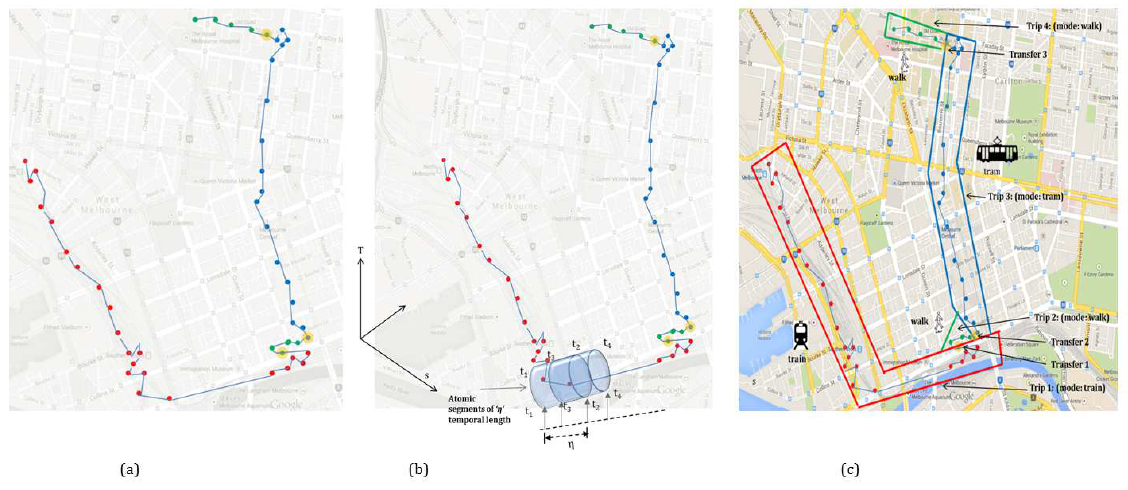
Figure 2. A raw trajectory is shown in Figure ( a ); Atomic segments are generated using an atomic kernel of time length η on the raw trajectory in Figure ( b ); Using a state-based bottom-up approach a given trajectory is then segmented into four segments that are detected as four distinct trips based on different transport modes with three transfers in Figure ( c